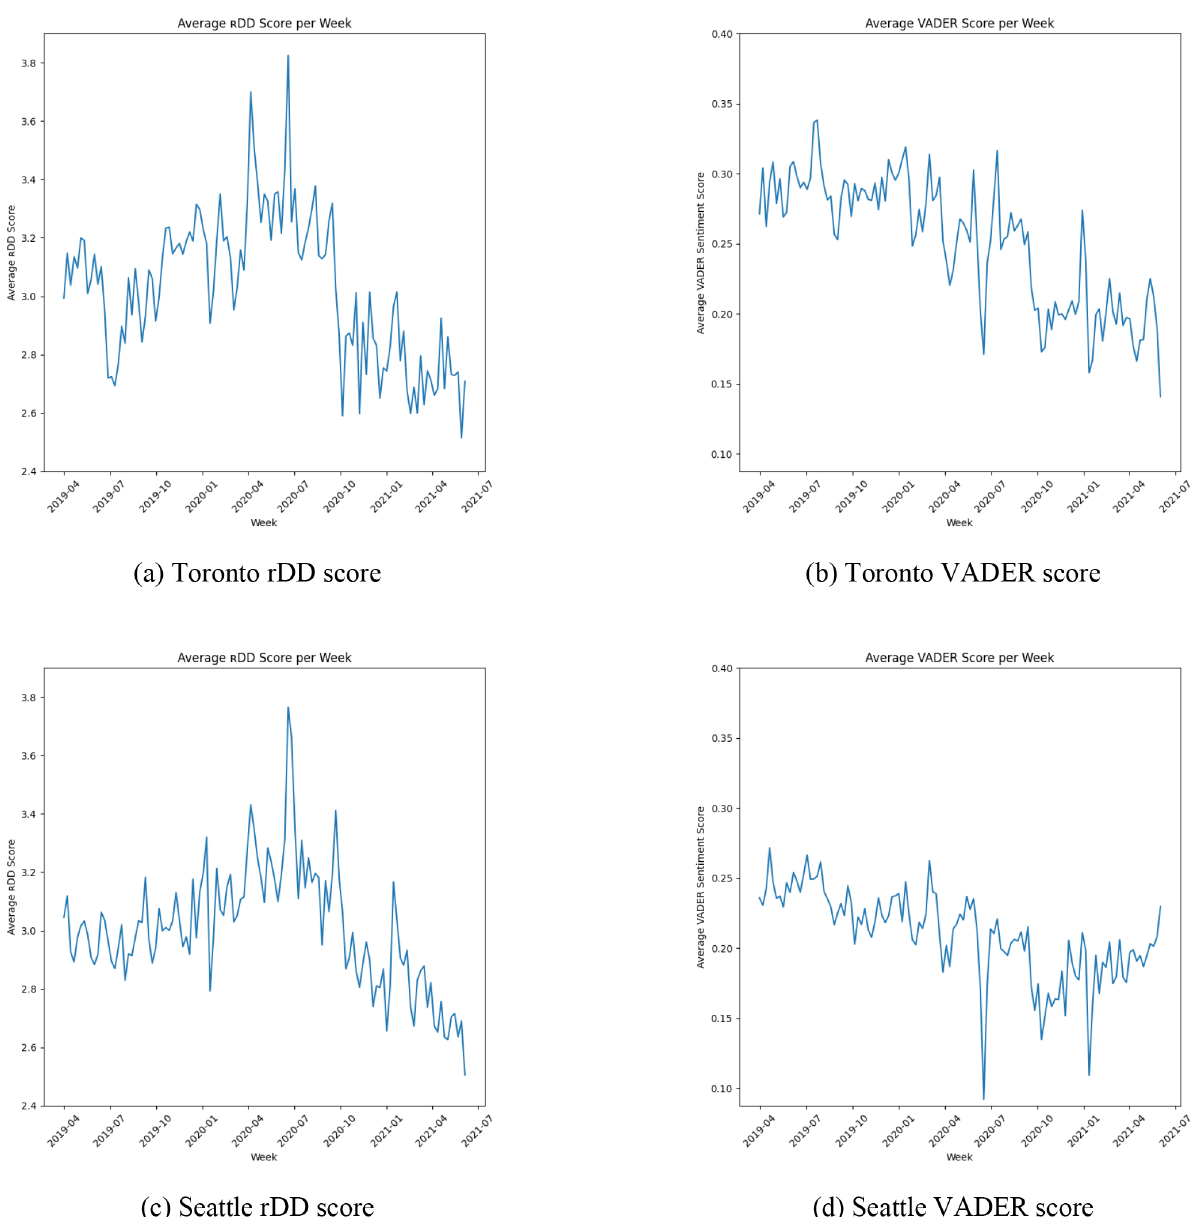
Figure 4: rDD and VADER Scores for Toronto and